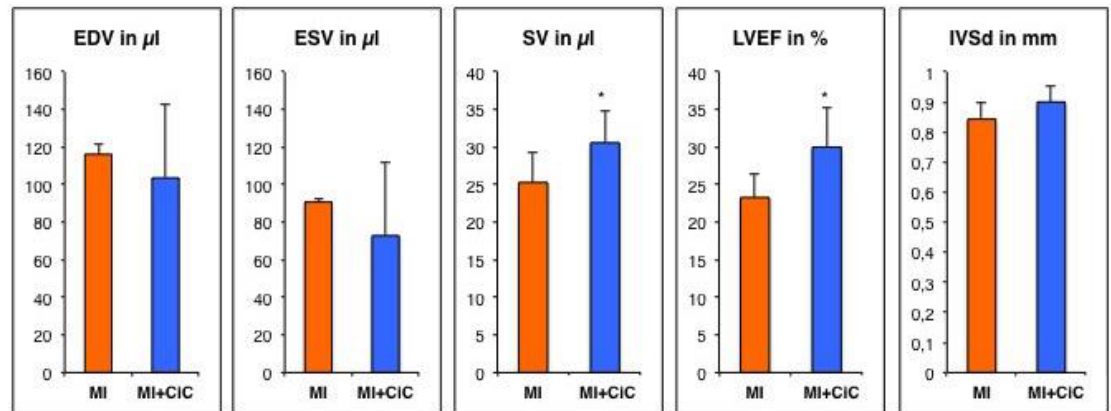
Figure 6. Effect of cardiac induced cells (CiC) transplantation on cardiac function and morphology measured by CMR three weeks after MI induction. Values are mean with SD. * p < 0.05 compared to MI group.